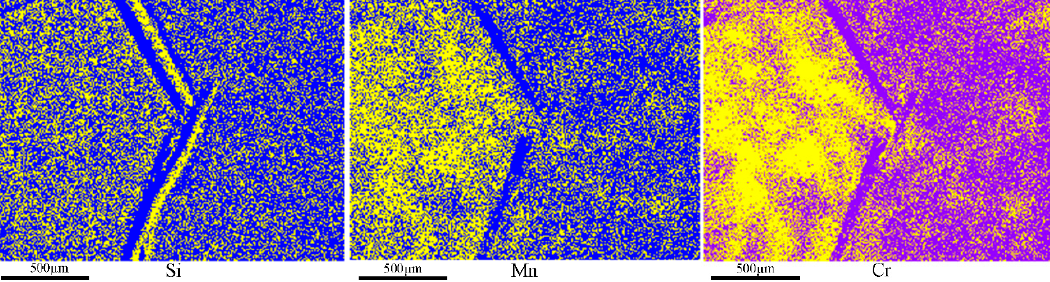
Figure 3. Element distribution mappings of the freckle region (left half) and its surrounding matrix. Table 2. Compositions and hardness of the freckle and the surrounding matrix.